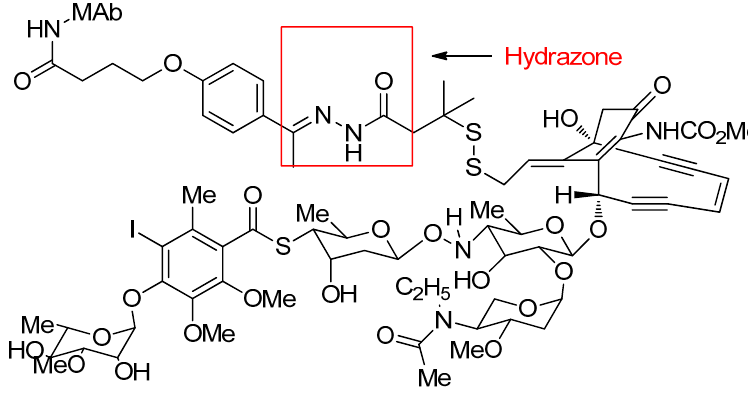
Figure 8. The structural formula of BR96-doxorubicin. Adapted from reference [56].